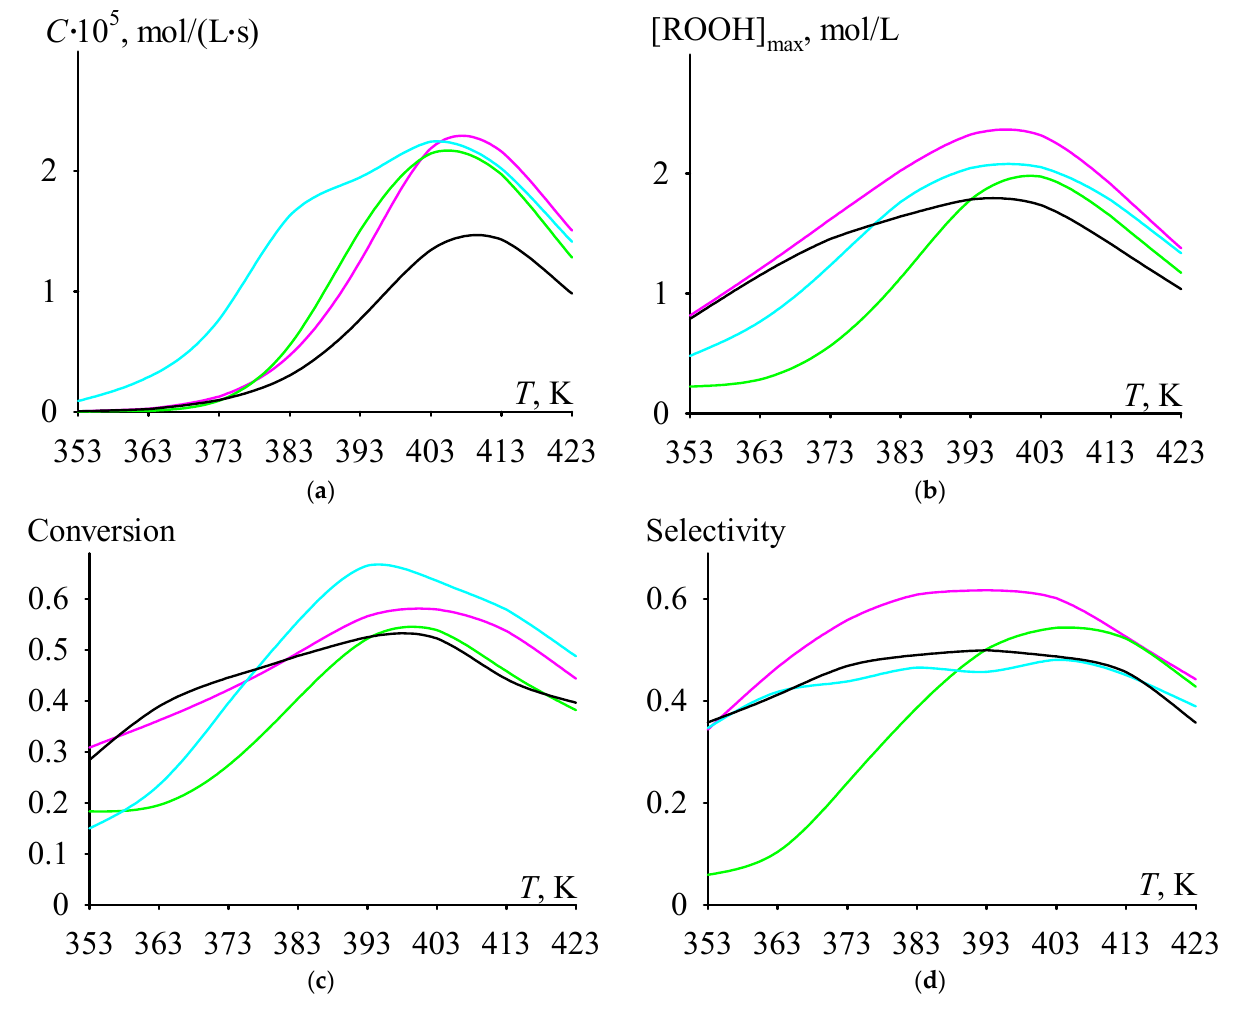
Figure 5. The dependencies of criterion C ( a ), [ROOH] max ( b ), cumene conversion at t max ( c ), and selectivity at t max ( d ) versus cumene oxidation temperature. Without catalyst Ca Sr Ba . G = 0.6 L/min, P = 1 atm, [RH] 0 = 6.19 mol/L, [ROOH] 0 = 0.15 mol/L, [ROH] 0 = 0.08 mol/L, [HCOOH] 0 = 0.018 mol/L, [C 6 H 5 C(O)CH 3 ] 0 = 0.024 mol/L, and [Cat] 0 = 1 mmol/L.